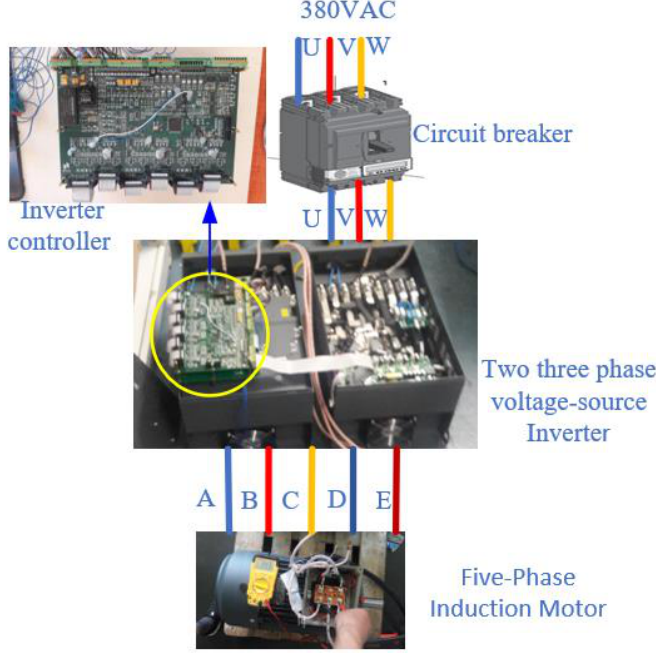
Figure 22. Five-phase induction motor control principle.